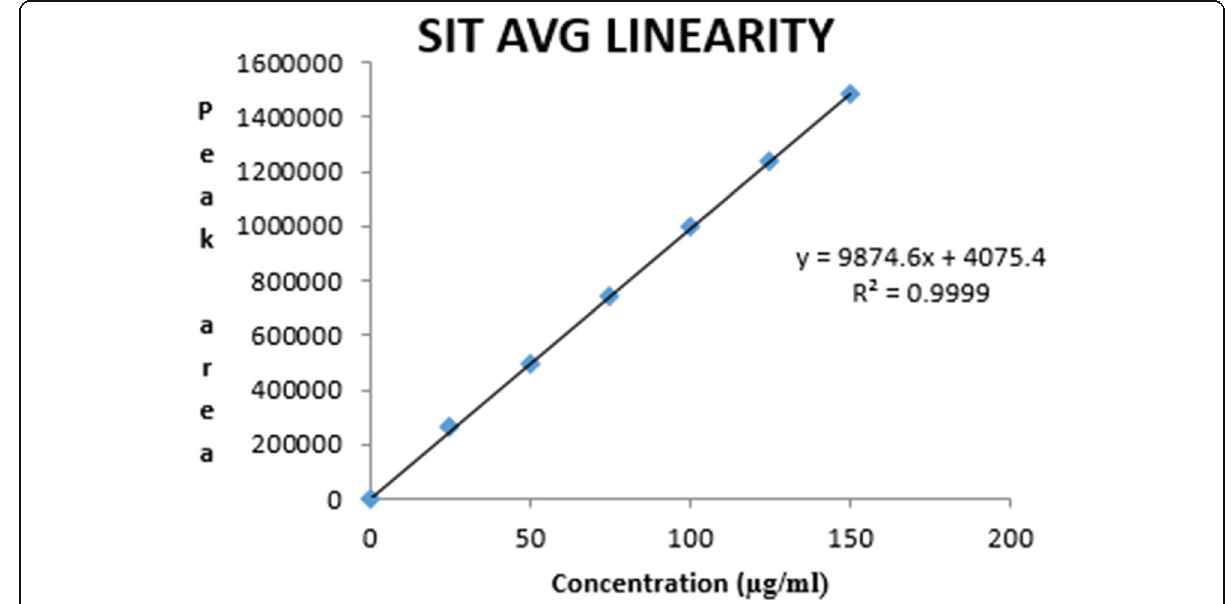
Fig. 5 Linearity data of